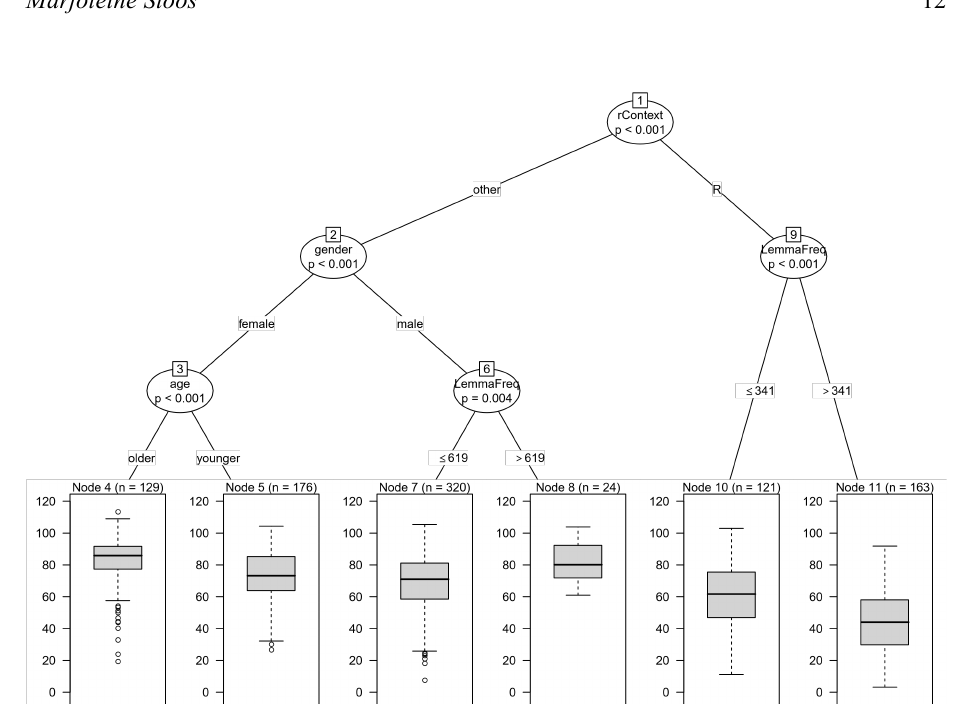
Figure 3: Classification tree for East Middle German, showing a conserving effect in non-pre- r context and a reducing effect in pre- r